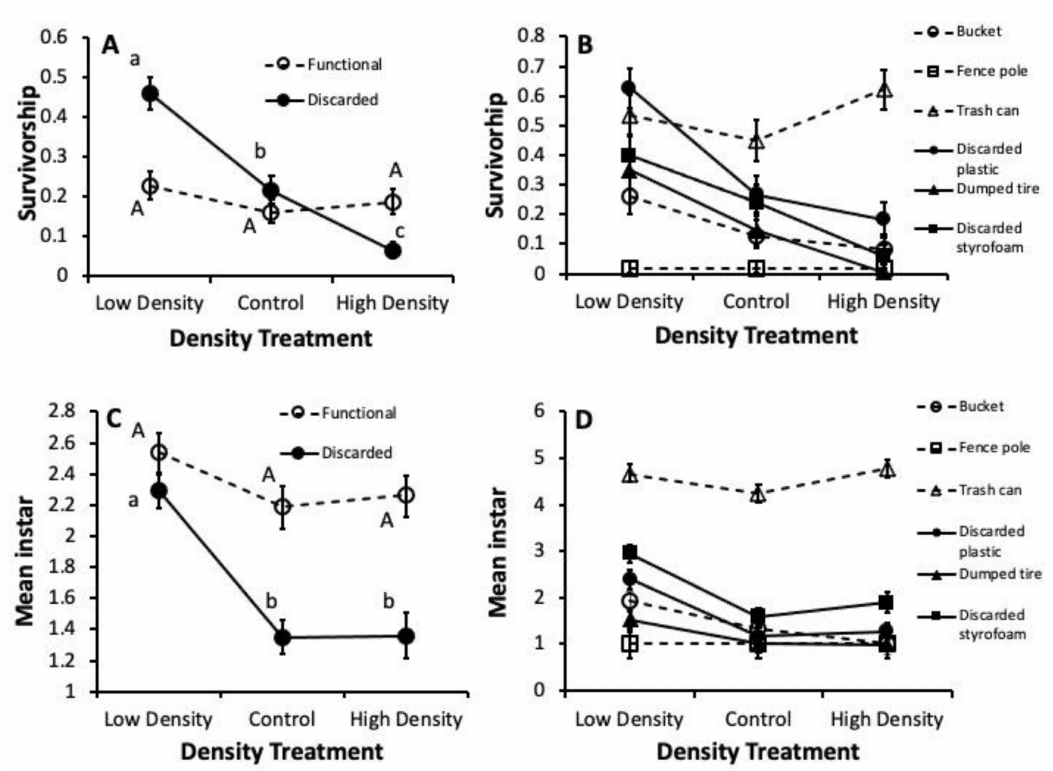
Figure 2. Least Squares Means (+SE) for competition treatments across broad container categories and container types for ( A , B ) survival of C. pipiens and ( C , D ) mean of instar of surviving C pipiens . Means within container categories associated with the same letter are not significantly different (Bonferroni test, experimentwise α = 0.05). Different means within container types are not denoted with letters for